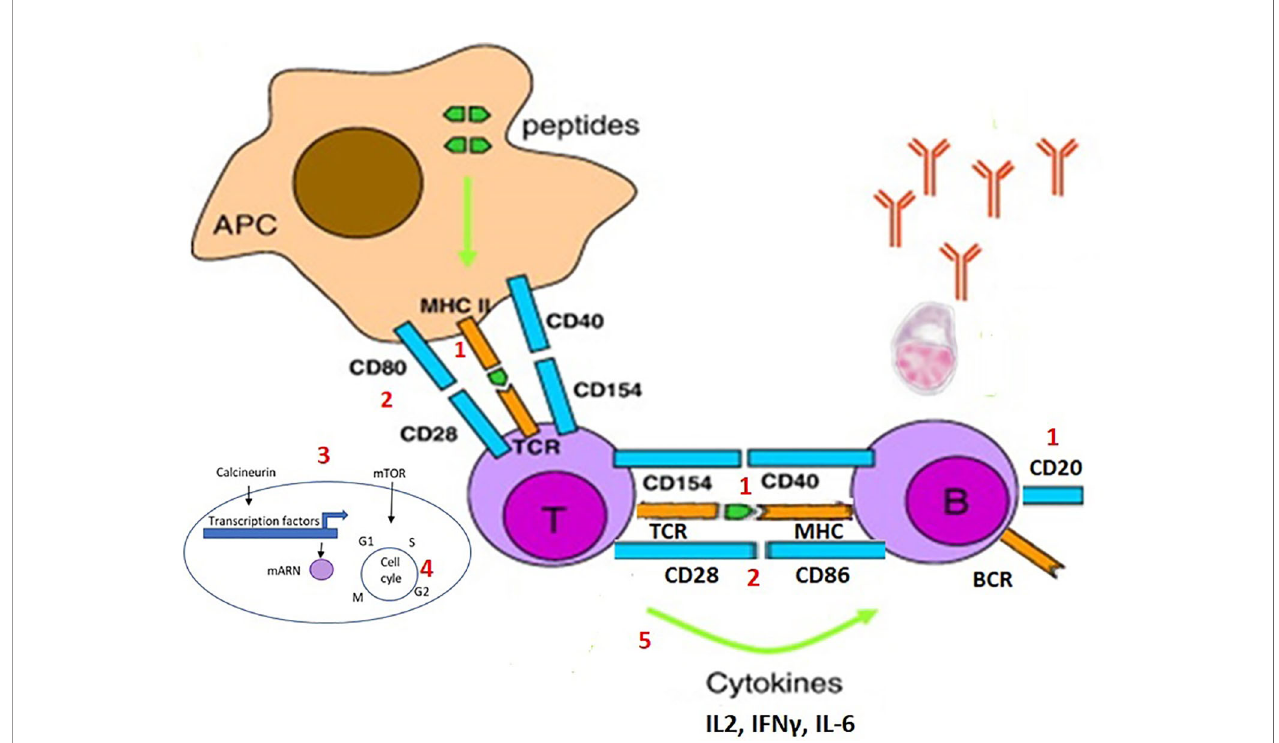
FIGURE 2 | Steps of the activation and proliferation of T cells and B cells during an immune response, and possible targets of the immunosuppresive drugs. During an immune response, naïve T cells recognize a peptide antigen presented on the surface of antigen-presenting cells (APCs) in the MHC molecule via the binding of their T-cell receptor (TCR) and co-stimulatory signals given by the CD80 and CD86 on the surface of DCs and CD28 on T cells. This activates various signal transduction pathways in T cells, which activate the transcription of various factors that induce the expression of several molecules, such as IL-2. Naïve B cells that have bound antigen to their surface Ig receptors require co-stimulatory signals from T cells that are speci fi c for the same antigen. This allows initiating a germinal center reaction with proliferation and mutation of the antibody genes and then differentiate into antibody-producing plasma cells and memory B cells. Each of the steps of the immune response can be the target of an immunosuppressive drug: 1) the depletion of the speci fi c or cognate T and/or B cells (e.g. anti-CD20); 2) interference with the co-stimulatory signals (e.g. CTLA4-analog); 3) blockade of the intracellular signal (e.g. calcineurin inhibitor or mTOR inhibitor); 4) inhibition of DNA synthesis and cell proliferation (e.g. purine analog, or alkylating agents); 5) modulation of the effector T or B cell responses (various anticytokine monoclonal antibodies), included blocking in fl ammation reducing antigen presentation (anti-IL6, TNF, JAK,